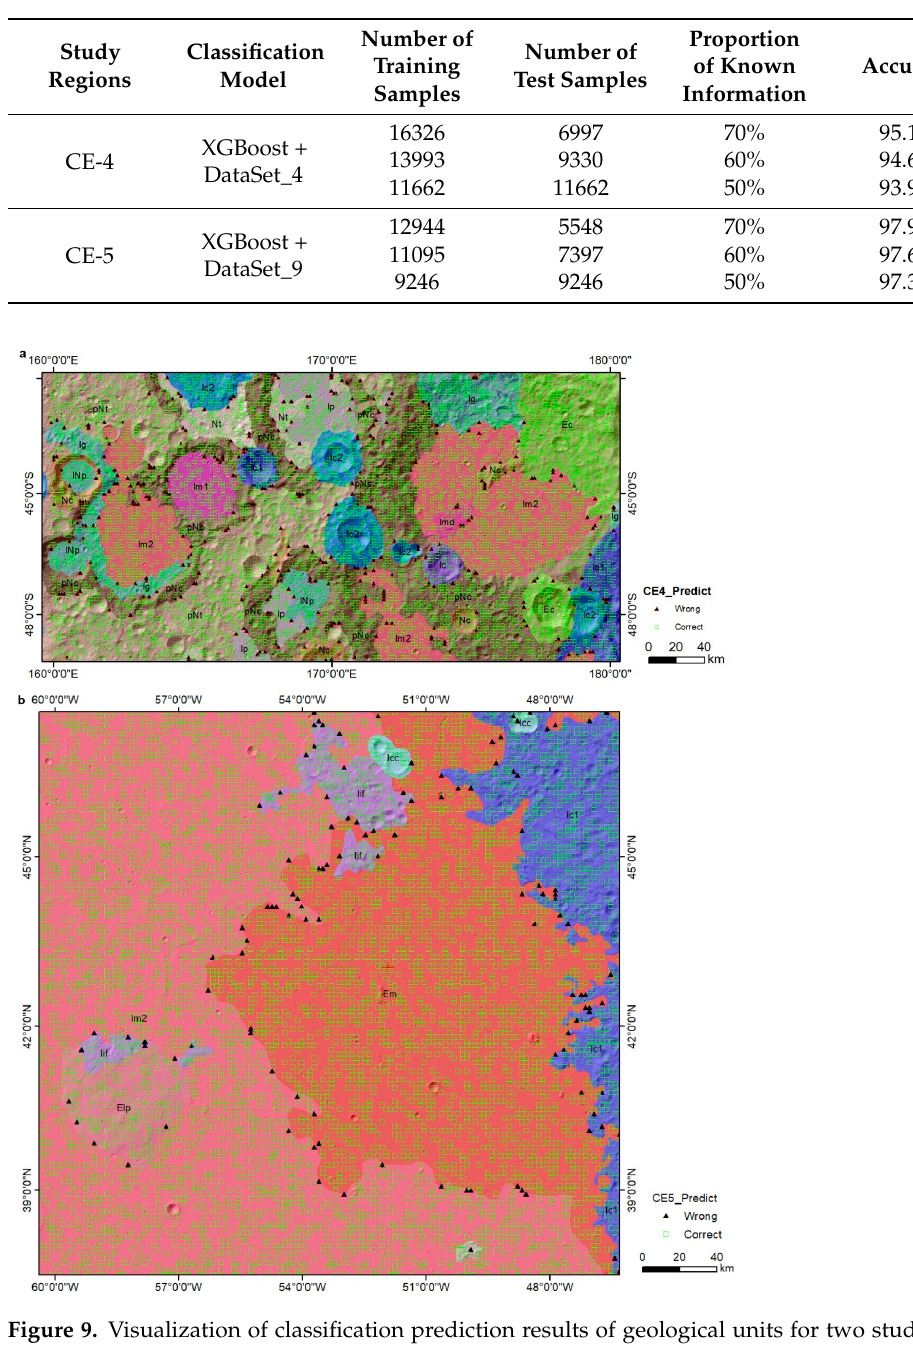
Table 3. Results of classification tests with different allocation ratios of known and unknown information.